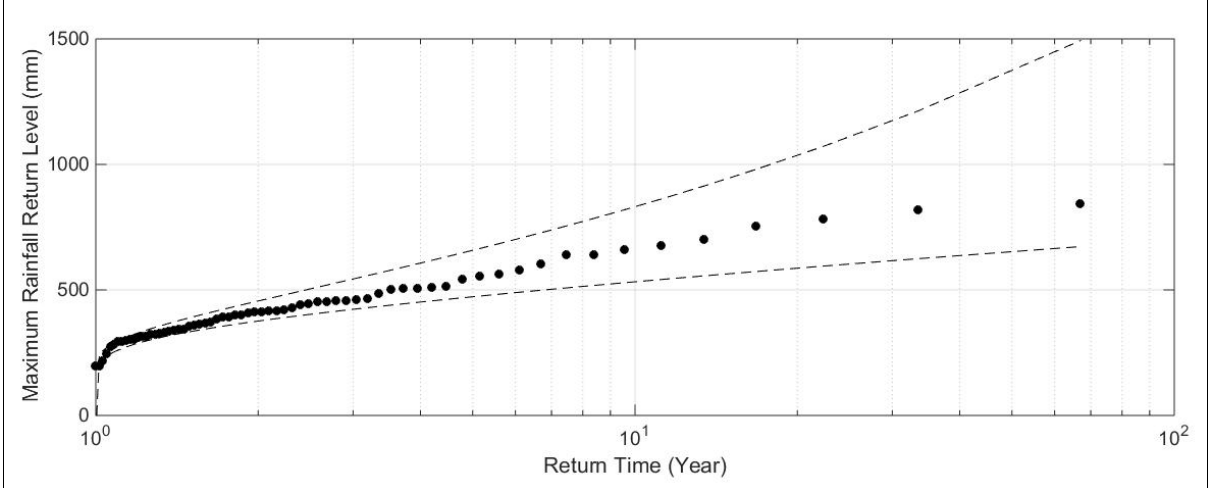
Figure 4: Yearly return level under generalised extreme value distribution over Mauritius during the period 1950–2016.